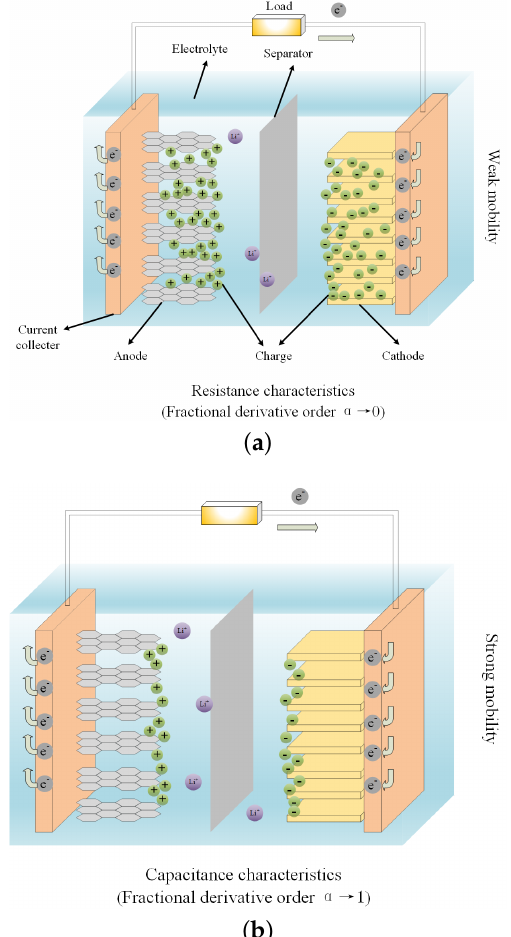
Figure 2. Fractal distribution of the charges on the porous electrodes: ( a ) high charge density; ( b ) low charge